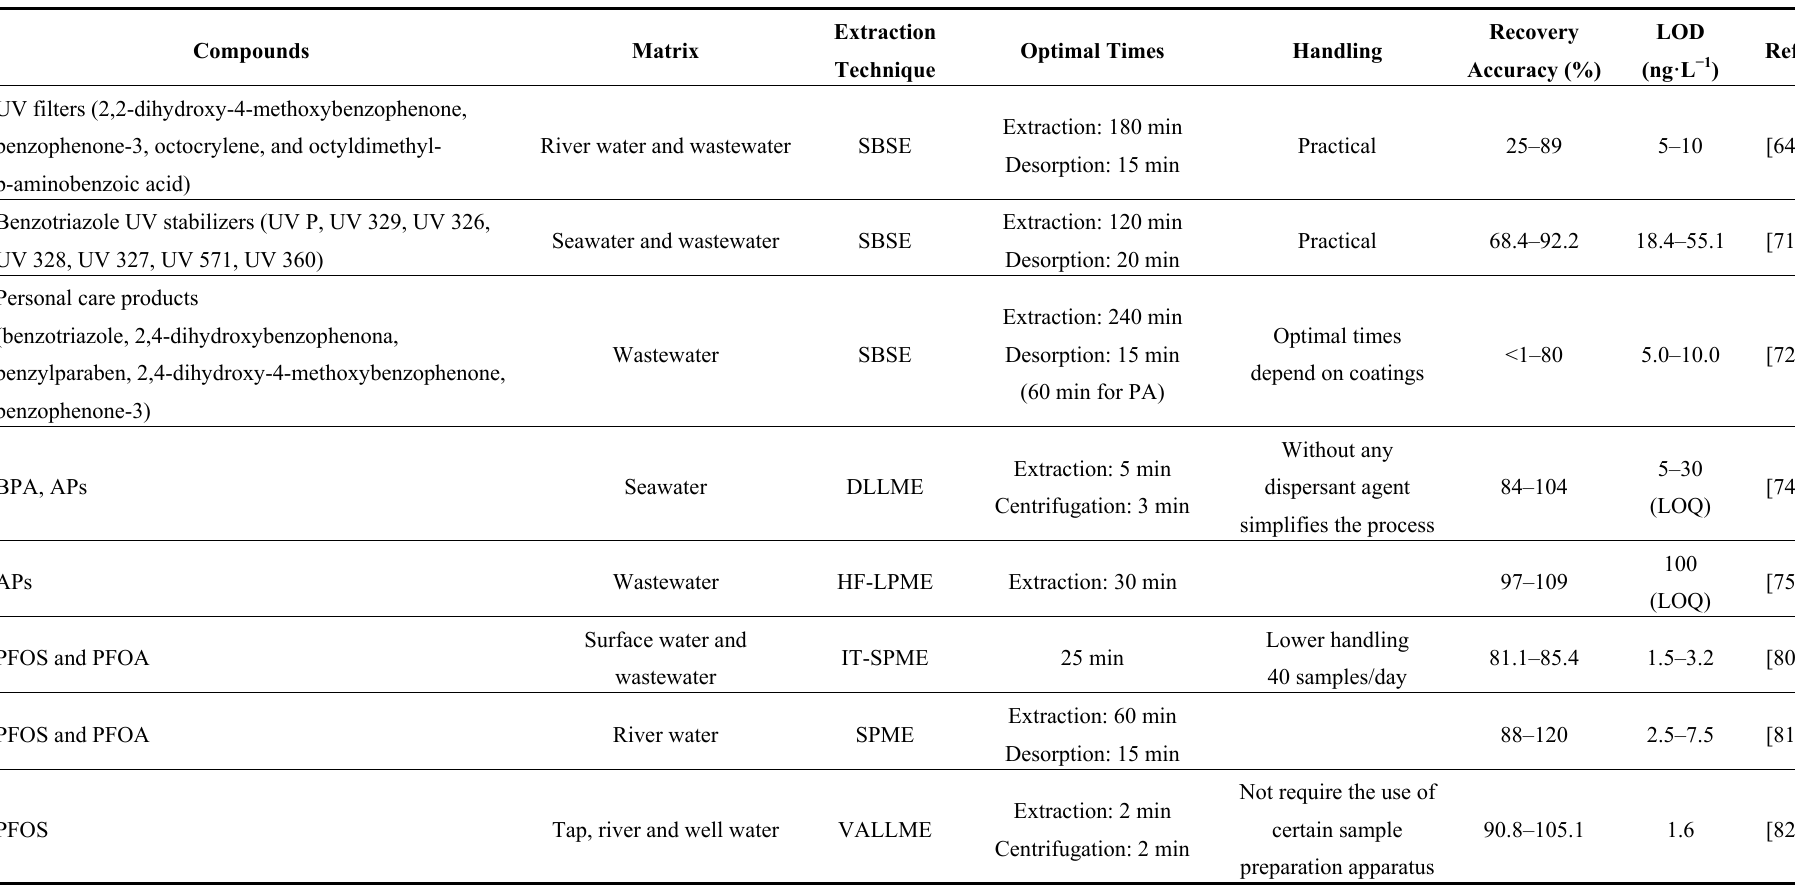
Table 2. Microextraction techniques to determine UV filters, alkyphenols, bisphenol A and PFCs in environmental water samples by liquid chromatography-tandem mass